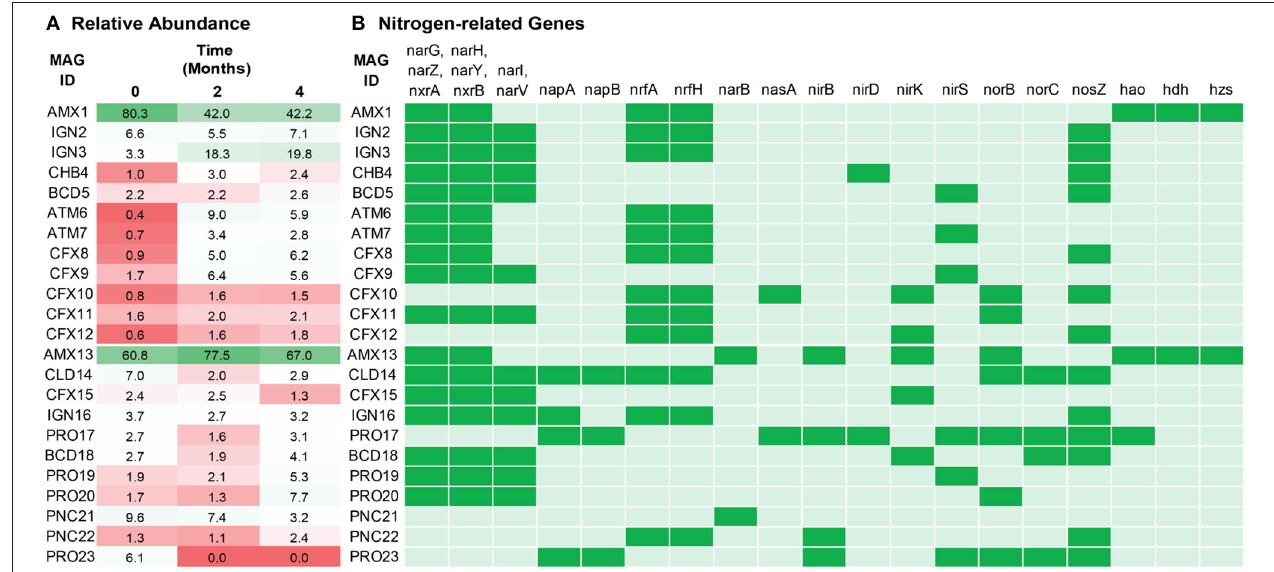
FIGURE 2 | (A) Relative abundance of the dominant organisms in freshwater (top) and marine water (bottom) reactor. Anammox bacteria (AMX1 and AMX13) were the most dominant bacteria in both ecosystems. Relative abundance is based on reads per million values of metagenomics reads that mapped to each MAG. (B) The presence/absence analysis of nitrogen related marker genes from the draft genomes annotated by KOALA (KEGG Orthology And Links Annotation). Green indicates the presence and light green indicate the absence of the marker